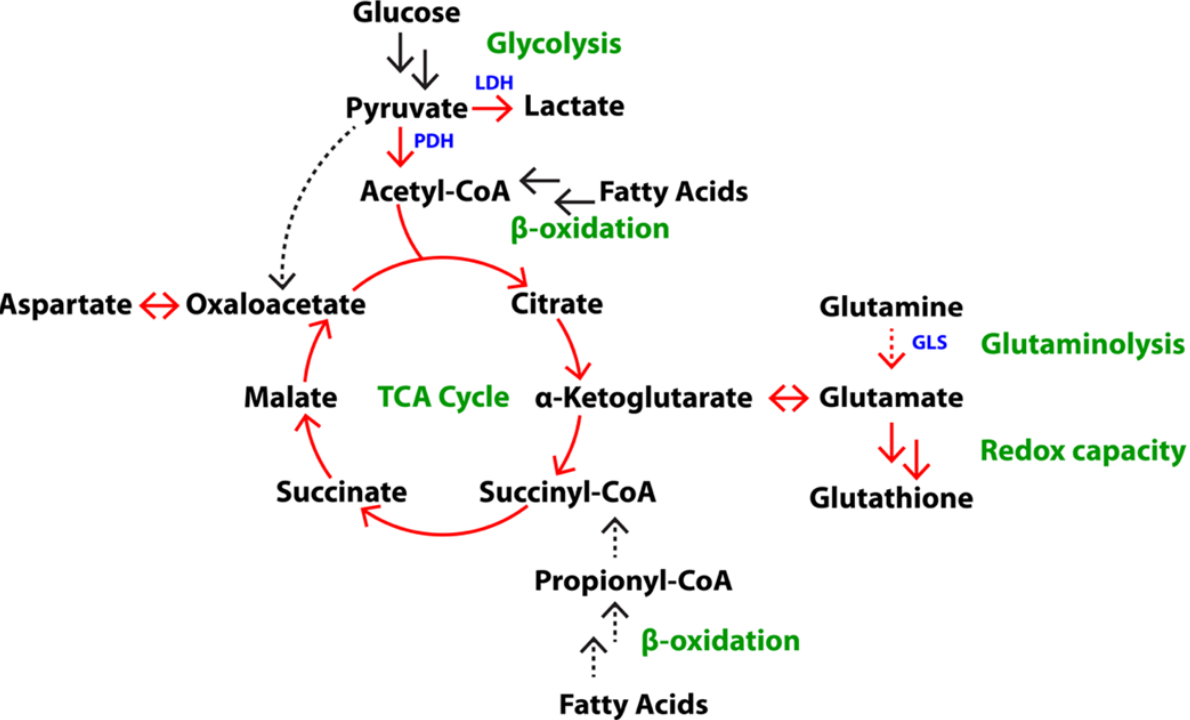
Figure 2. Overview of metabolic pathways associated with glucose and glutamine metabolism. Key metabolic pathways (green) and respective metabolites (black) and enzymes (blue) are shown. Red arrows indicate pathways that are particularly relevant to distinguishing CRPC from ADPC, doubled arrows represent simplified multistep processes, and dashed lines indicate anaplerotic pathways of the TCA cycle. Metabolites 2021 , 11 , x FOR PEER REVIEW 5 of 21